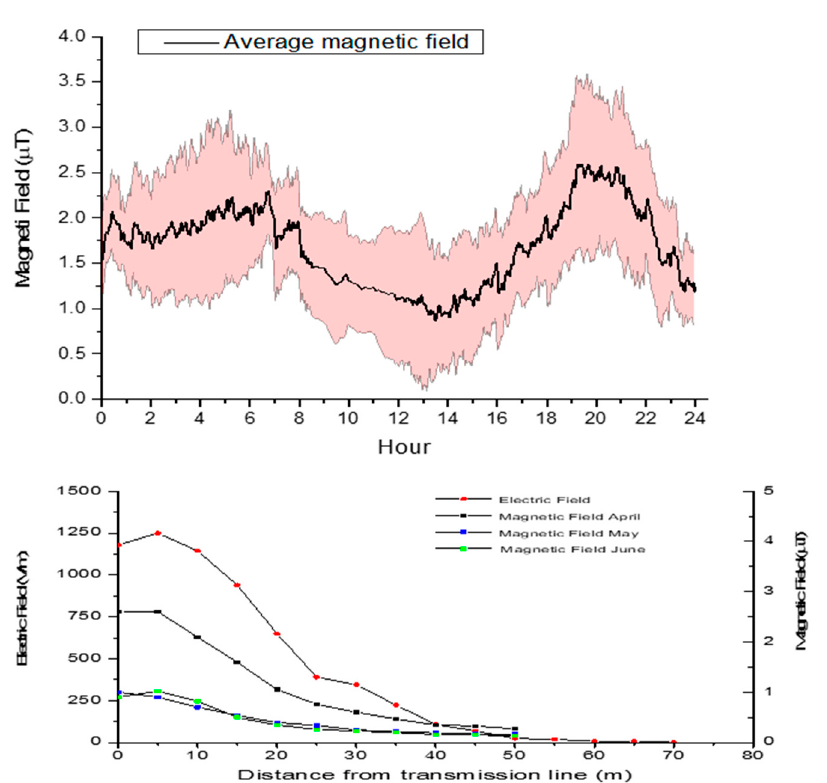
Figure 2. Mean daily cycle of the magnetic field below the transmission line (above) and the decreasing gradient of the magnetic and electric fields as a function of the distance from the transmission line (below). Table 2. List of commercial products (expressed as Kg a.i./hectare) in alphabetic order and their active ingredients used in 2017 in the orchard farm where exposure site was located.